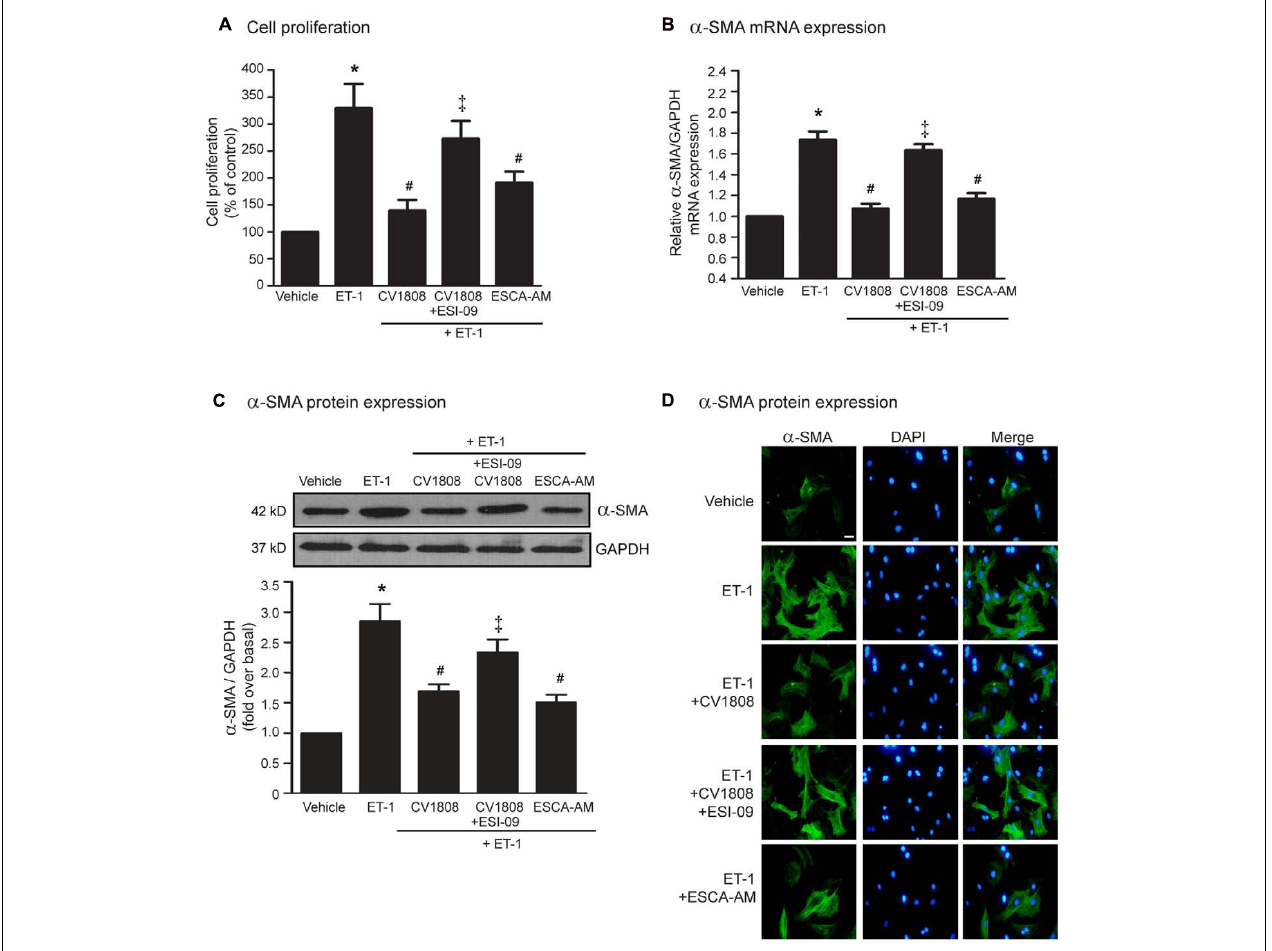
FIGURE 4 | Stimulation of A 2 receptors inhibits ET-1-induced cell proliferation and α -SMA synthesis in an Epac-dependent pathway. (A–D) Cardiac fibroblasts were pretreated without or with 10 µ M ESI-09 (Epac inhibitor) for 1 h. After 1 h, cells were treated with vehicle (control), 10 µ M ESCA-AM (Epac activator), or 10 µ M CV1808 for 1 h and further stimulated with 20 nM ET-1 for 12 h (B) or 24 h (A,C,D) at 37 ◦ C. (A) Cell proliferation was quantified by MTT assay. The data were expressed as the percentage relative to the non-treated group, and shown as mean ± SEM ( n = 4). ∗ P < 0.05 vs. vehicle; # P < 0.05 vs. ET-1; ‡ P < 0.05 vs. CV1808+ET-1. (B,C) Relative α -SMA mRNA (B) and protein (C) levels were quantified and shown as the mean ± SEM ( n = 4). ∗ P < 0.05 vs. vehicle; # P < 0.05 vs. ET-1; ‡ P < 0.05 vs. CV1808+ET-1. (D) Cells were incubated with anti- α -SMA antibody followed by goat anti-mouse antibody (Alexa Fluor 488). The α -SMA was visualized by fluorescent microscope. Cells were stained for α -SMA (green) and nuclear staining of nucleus with DAPI (blue). Bar, 10 µ